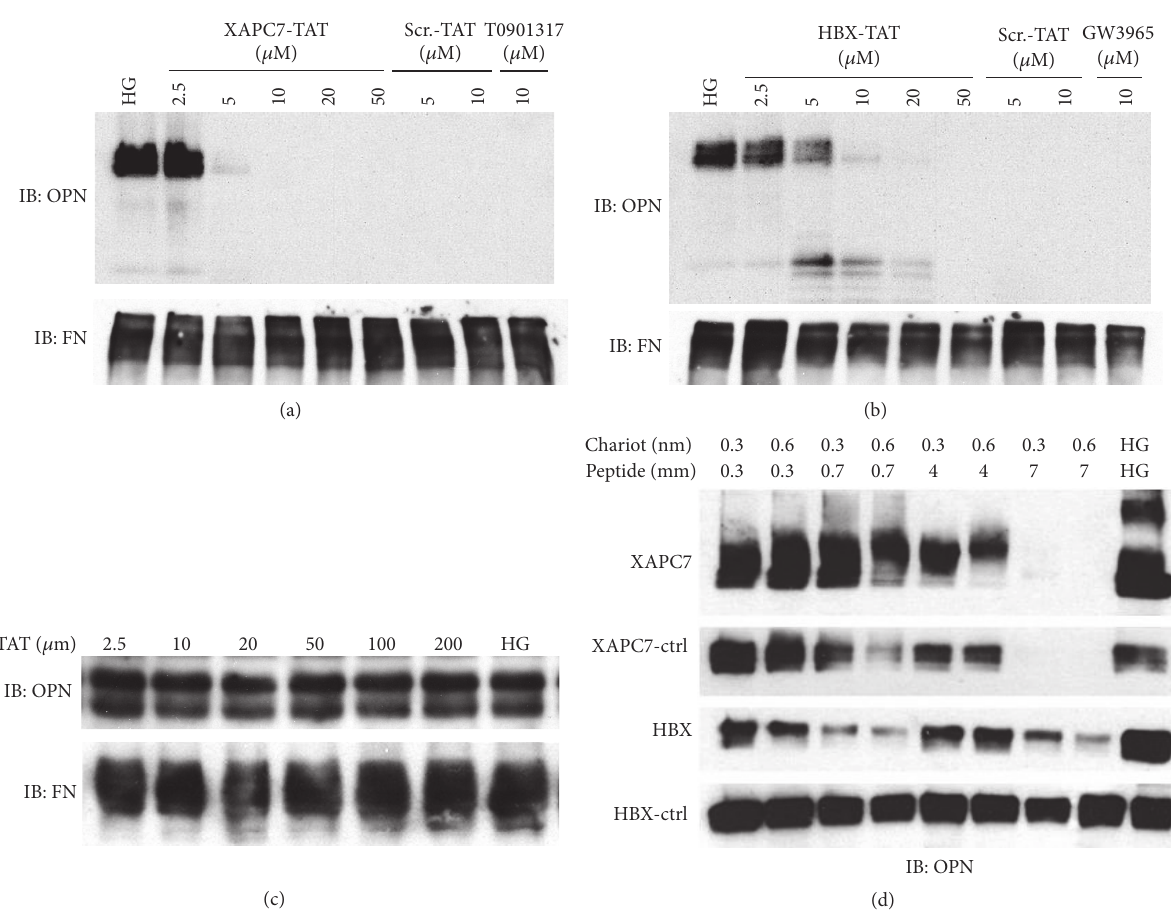
Figure 6: The XAPC7 and HBX peptides inhibit the high glucose-induced OPN production in cultured mesangial cells. (a) Western blot analysis of the conditioned media of cultured wild type mesangial cells treated with XAPC7-TAT and scrambled XAPC7-TAT or (b) HBX- TAT and scrambled HBX-TAT peptides under high glucose (HG, 25mM) conditions. (c) Western blot analysis of the conditioned media of cultured wild type mesangial cells treated with TAT peptide under high glucose (25 mM) conditions. (d) Western blot analysis of the conditioned media of cultured wild type mesangial cells treated with Chariot/XAPC7, Chariot/HBX, and Chariot/scramble peptides under high glucose conditions